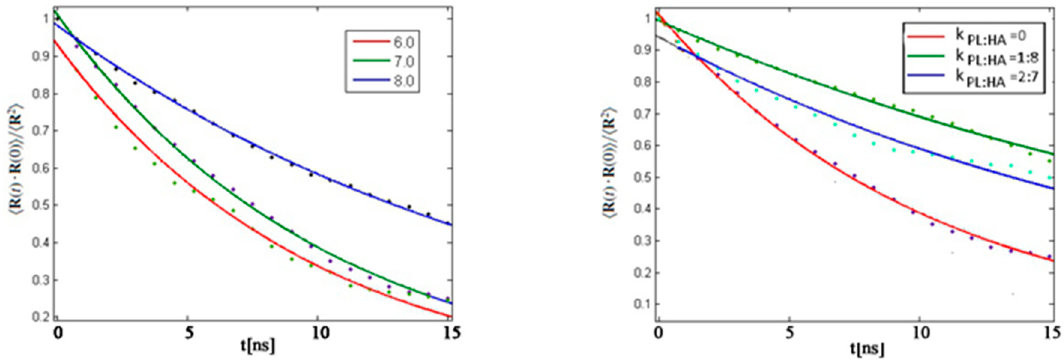
Figure 8. Autocorrelation function of the HA end-to-end vector. ( Left ) HA without DPPC for different pH values; ( Right ) HA with DPPC for pH = 7. The fit has been made using Equation (7). The legend indicates pH values.